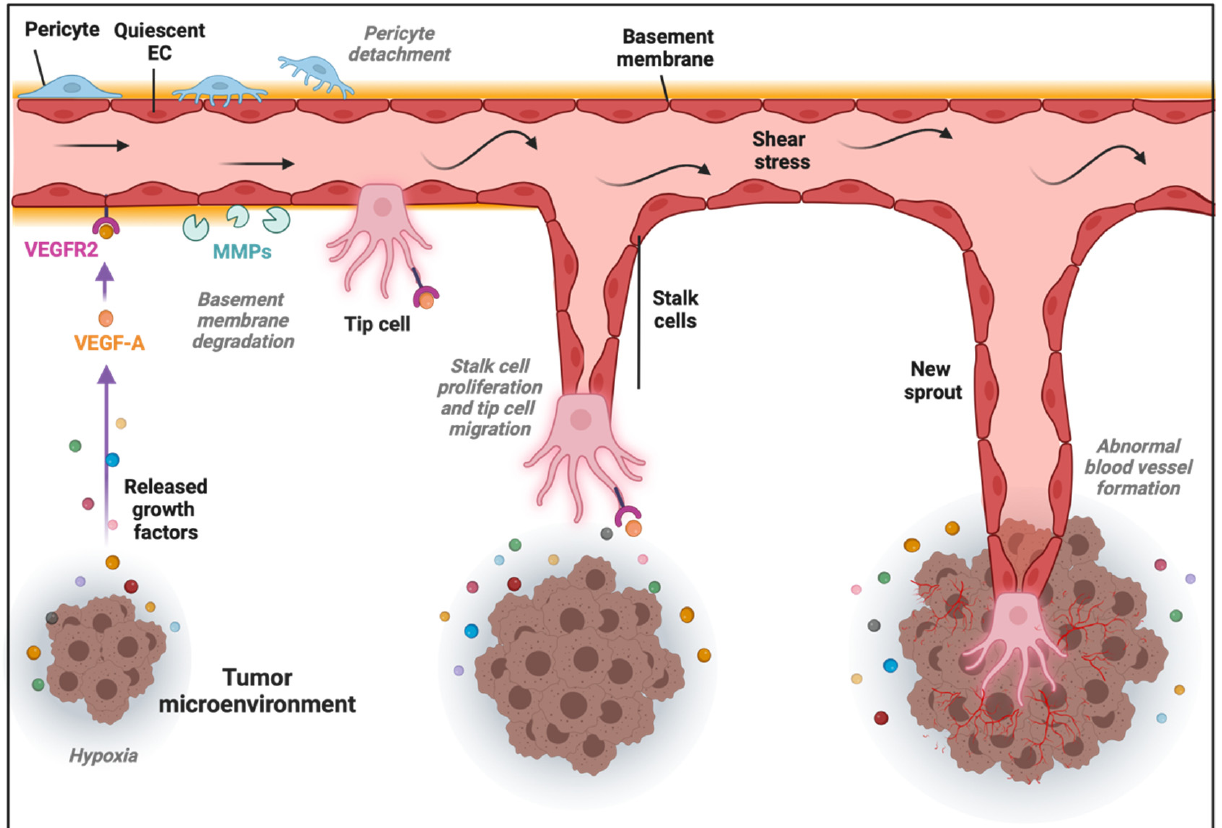
Figure 1. Sprouting angiogenesis in the tumor microenvironment (TME). Angiogenic stimuli such as hypoxia and proangiogenic growth factor gradients (in part produced by cancer cells) induce tip and stalk cell formation in a preexisting blood vessel. VEGF binds and activates its receptor VEGFR2, ECs become activated, and the detachment of pericytes and degradation of basement membrane and extracellular matrix (ECM) by matrix metalloproteinases (MMPs) take place. The tip cell becomes motile and starts to form lamellipodia and filopodia to migrate, while stalk cells proliferate to elongate the nascent vessel sprout in the TME.